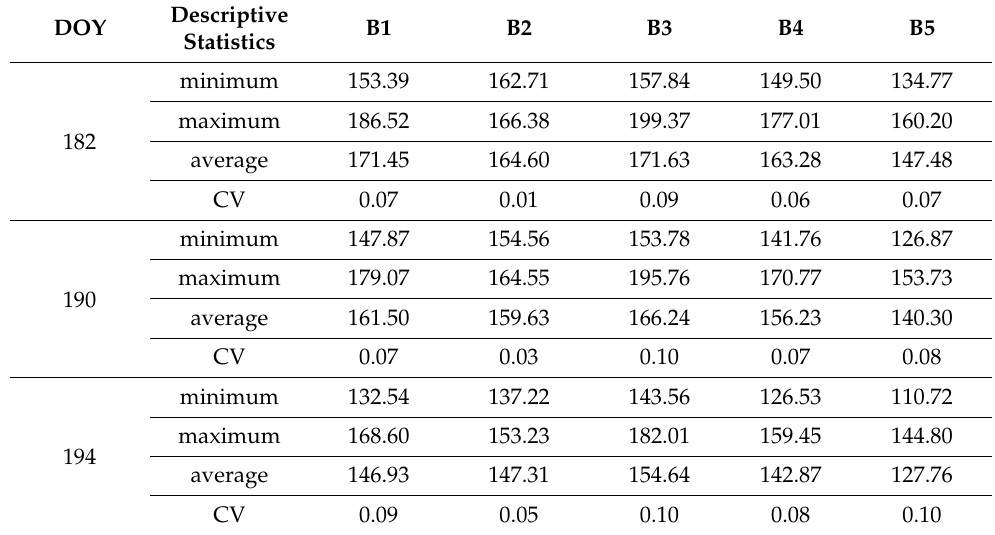
Table 4. Statistics for soil water content ( θ ; mm) for the three dates